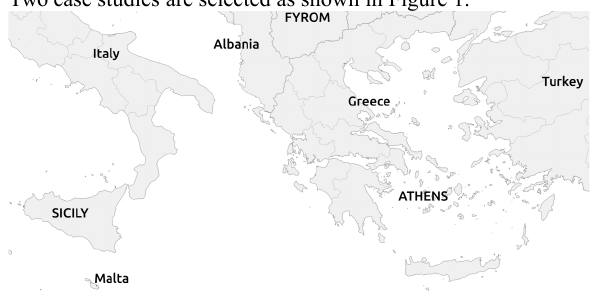
Figure 1. The study areas. Sicily and